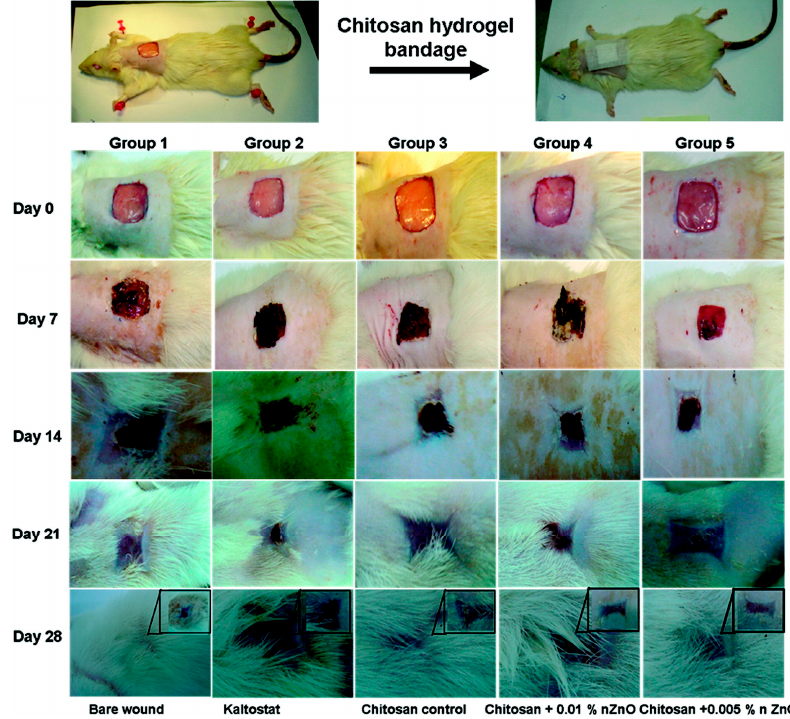
Figure 19. Photographs of an in vivo wound healing study. Note the extent of wound closure in the wounds treated with chitosan control and the chitosan hydrogel/ZnO NP composite bandages. Reproduced with permission from reference [24]. Copyright (2012) American Chemical Society.